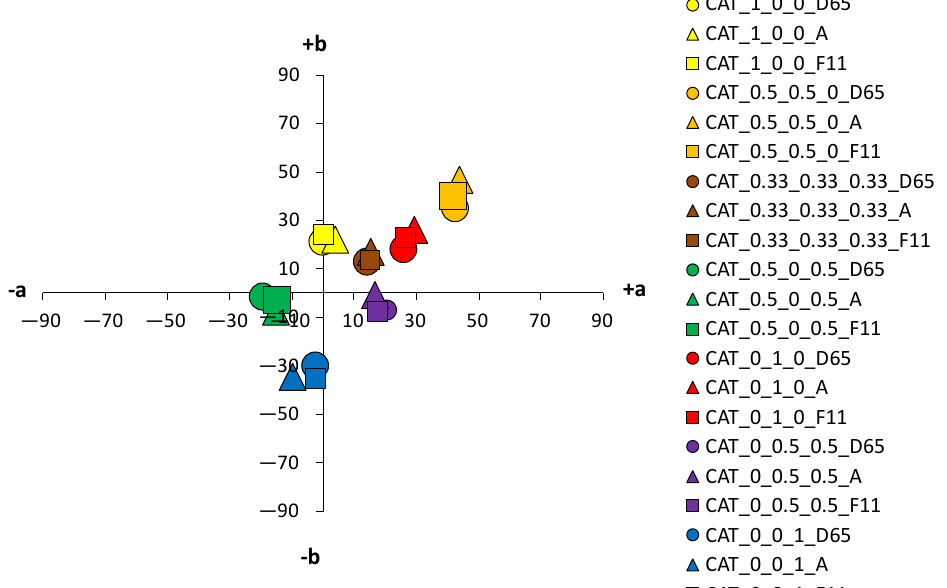
Figure 9. Color coordinates of cationized cotton fabric dyed with 1% owf dyes under different light sources.